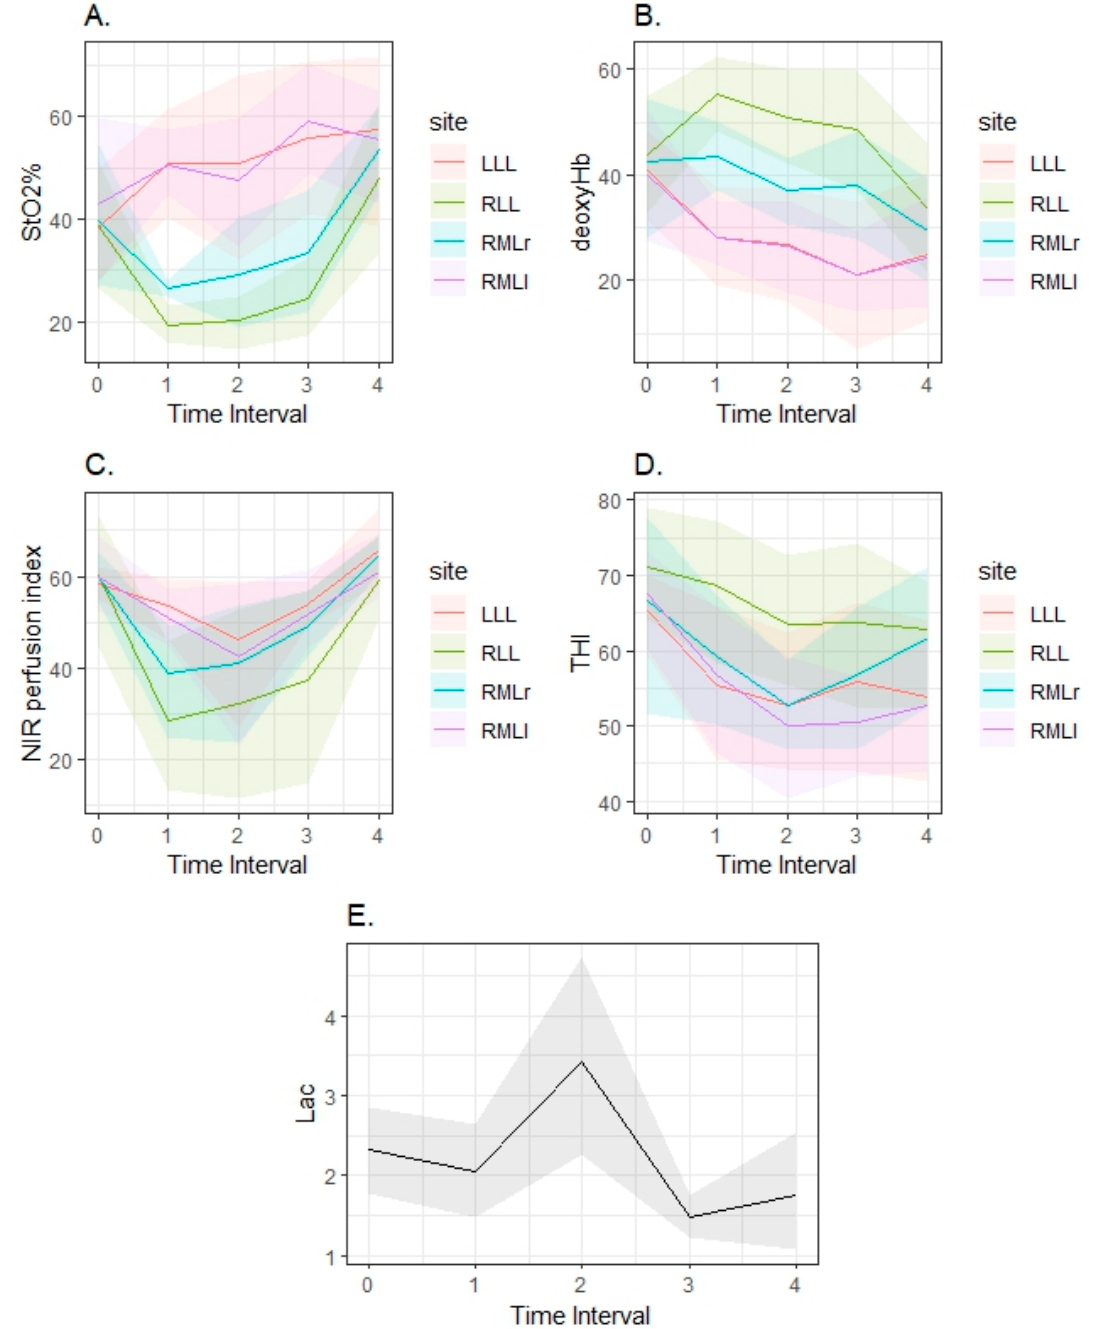
Figure 3. Trends of each index during time in the different liver lobes. ( A ) Oxygen saturation, ( B ) deoxygenated hemoglobin, ( C ) near-infrared perfusion index, ( D ) total hemoglobin index, ( E ) lactates.